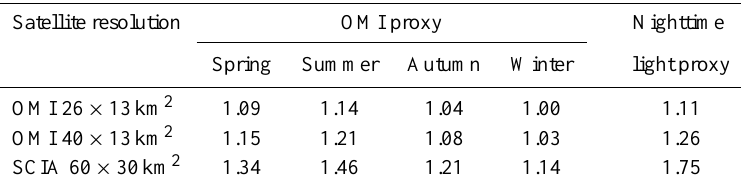
Table 6. Smoothing factors, i.e. the ratio of “true” and smoothed NO 2 VCD at the measurement site, estimated for OMI (for 26 × 13km 2 and 40 × 13km 2 pixel size) and SCIAMACHY (for 60 × 30 km 2 pixel size) resolution, using multi-year seasonal mean OMI VCDs and nighttime lights as proxy for the “true” NO 2